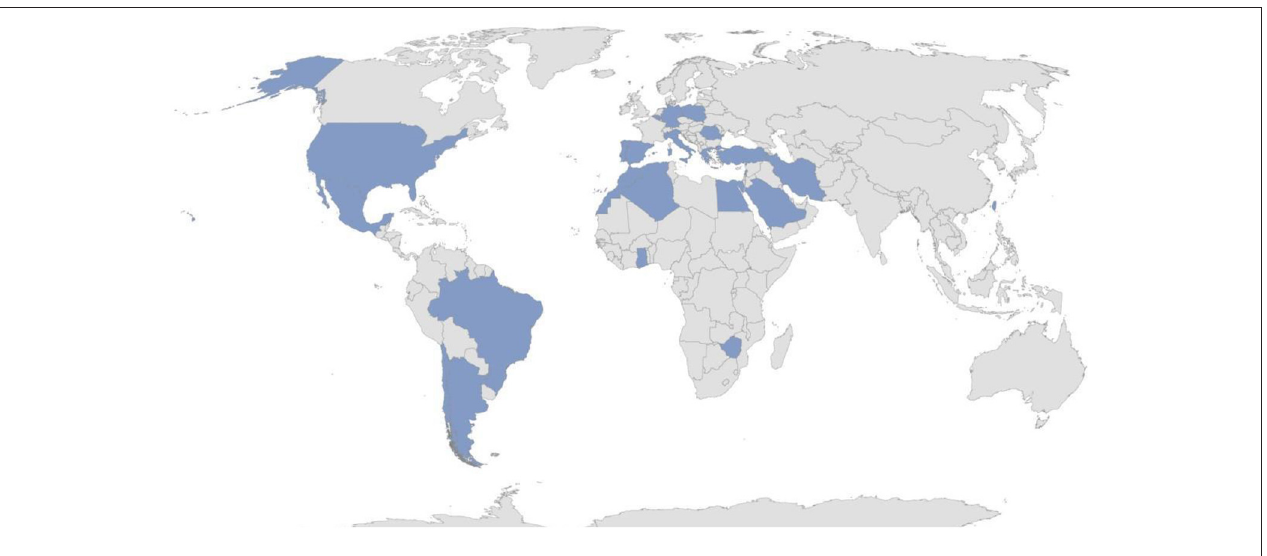
FIGURE 1 | Worldwide distribution of the AIDA network in February 2022.